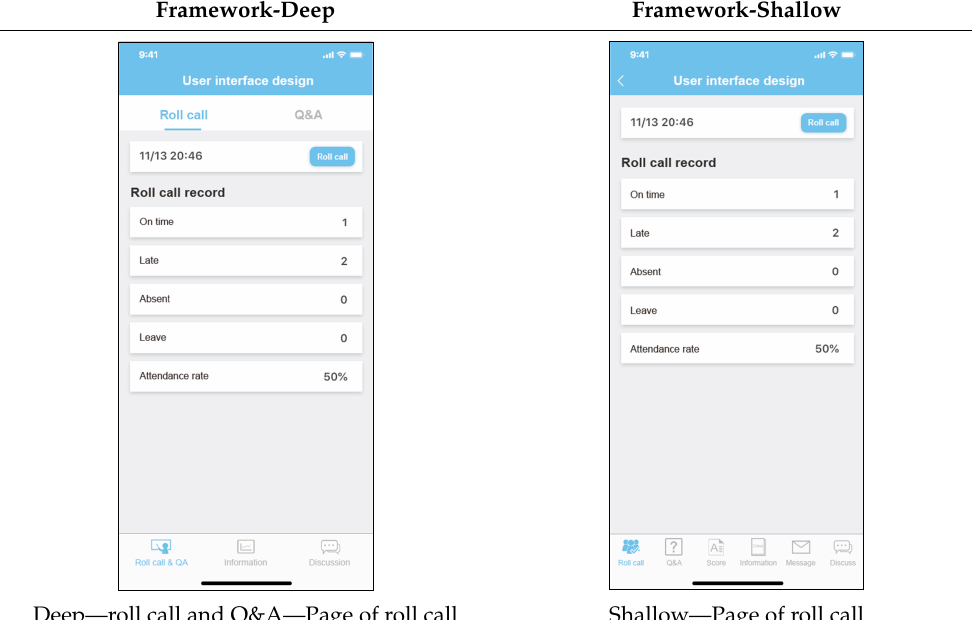
Table 6. Experimental sample.